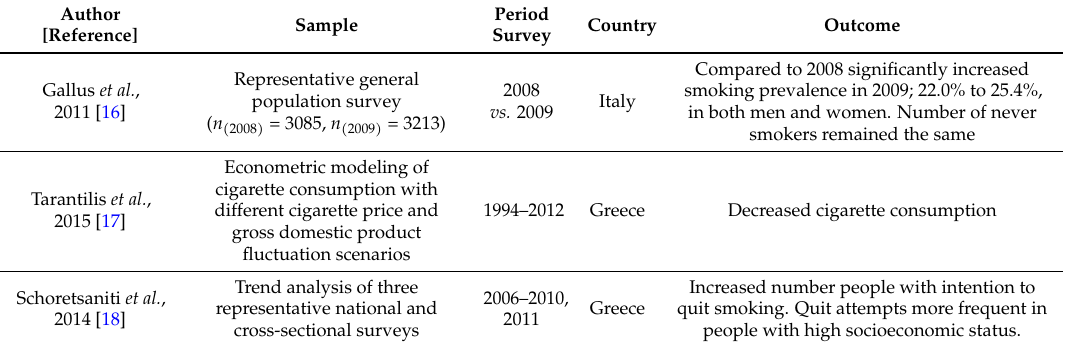
Table 2. Studies on cigarette smoking during and after the economic crisis in European Union